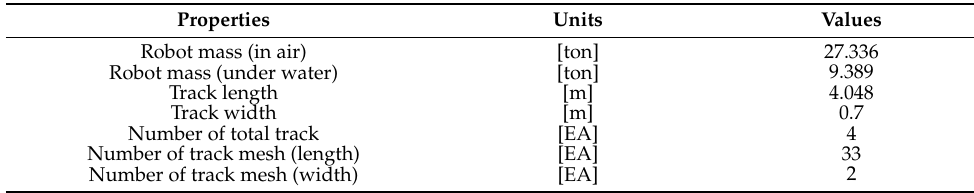
Table 3. Model information of mining